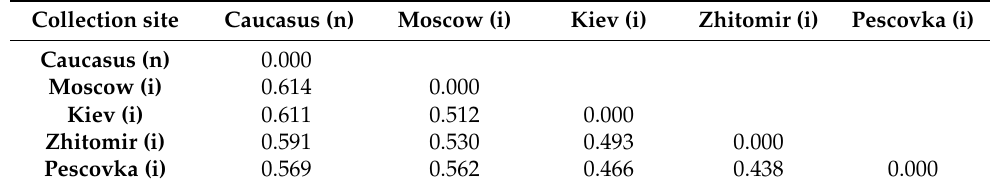
Table 5. Genetic diversity between the analysed populations of H. sosnowskyi calculated according to Nei and Li using the combination of methods RAPD, ISSR and REMAP.